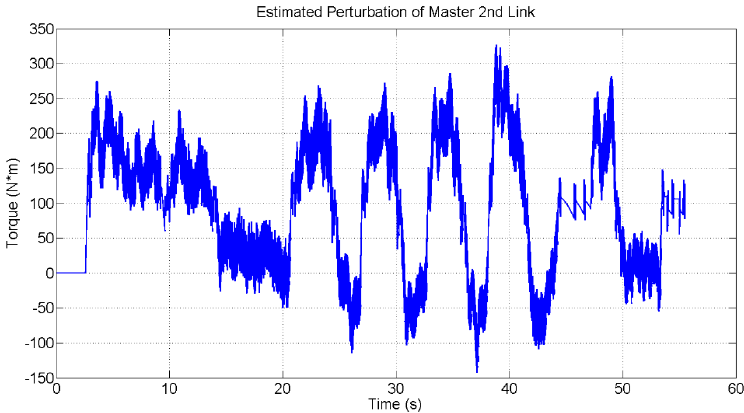
Figure 17. Error between master–slave trajectories for 2nd link.